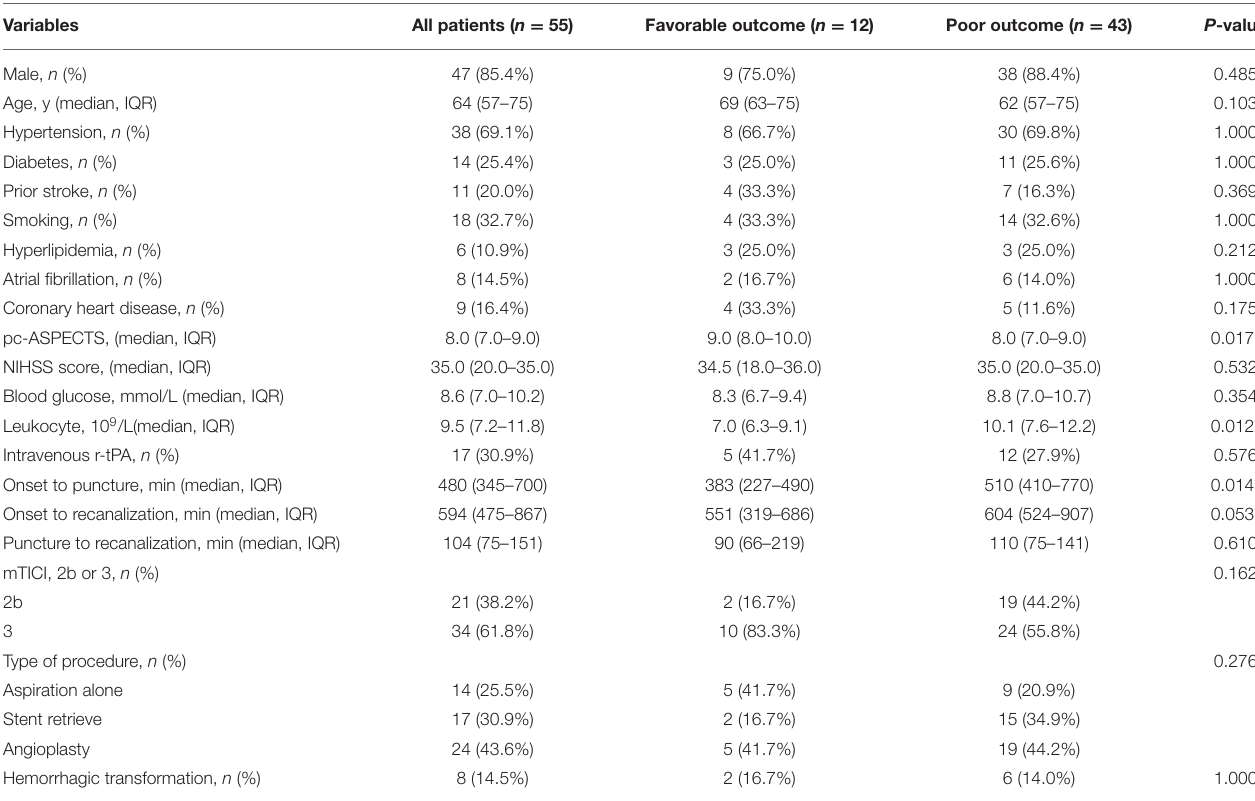
TABLE 1 | Characteristics and clinical data of the BAO patients treated with EVT. Variables All patients ( n = 55)